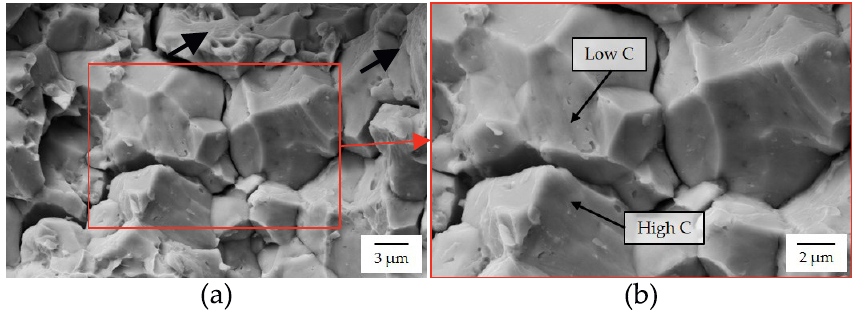
Figure 11. ( a ) Mainly brittle intergranular fracture surface of QP170_300 tensile test sample containing small ductile areas and cracks; ( b ) crack running between microstructural areas with relatively low and high C content measured by